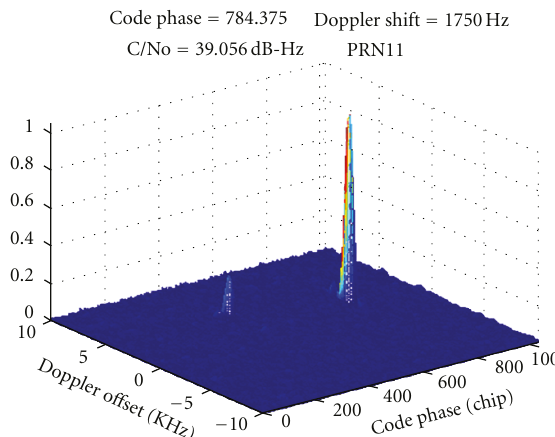
Figure 11: Acquisition result for PRN 11 using proposed algorithm.